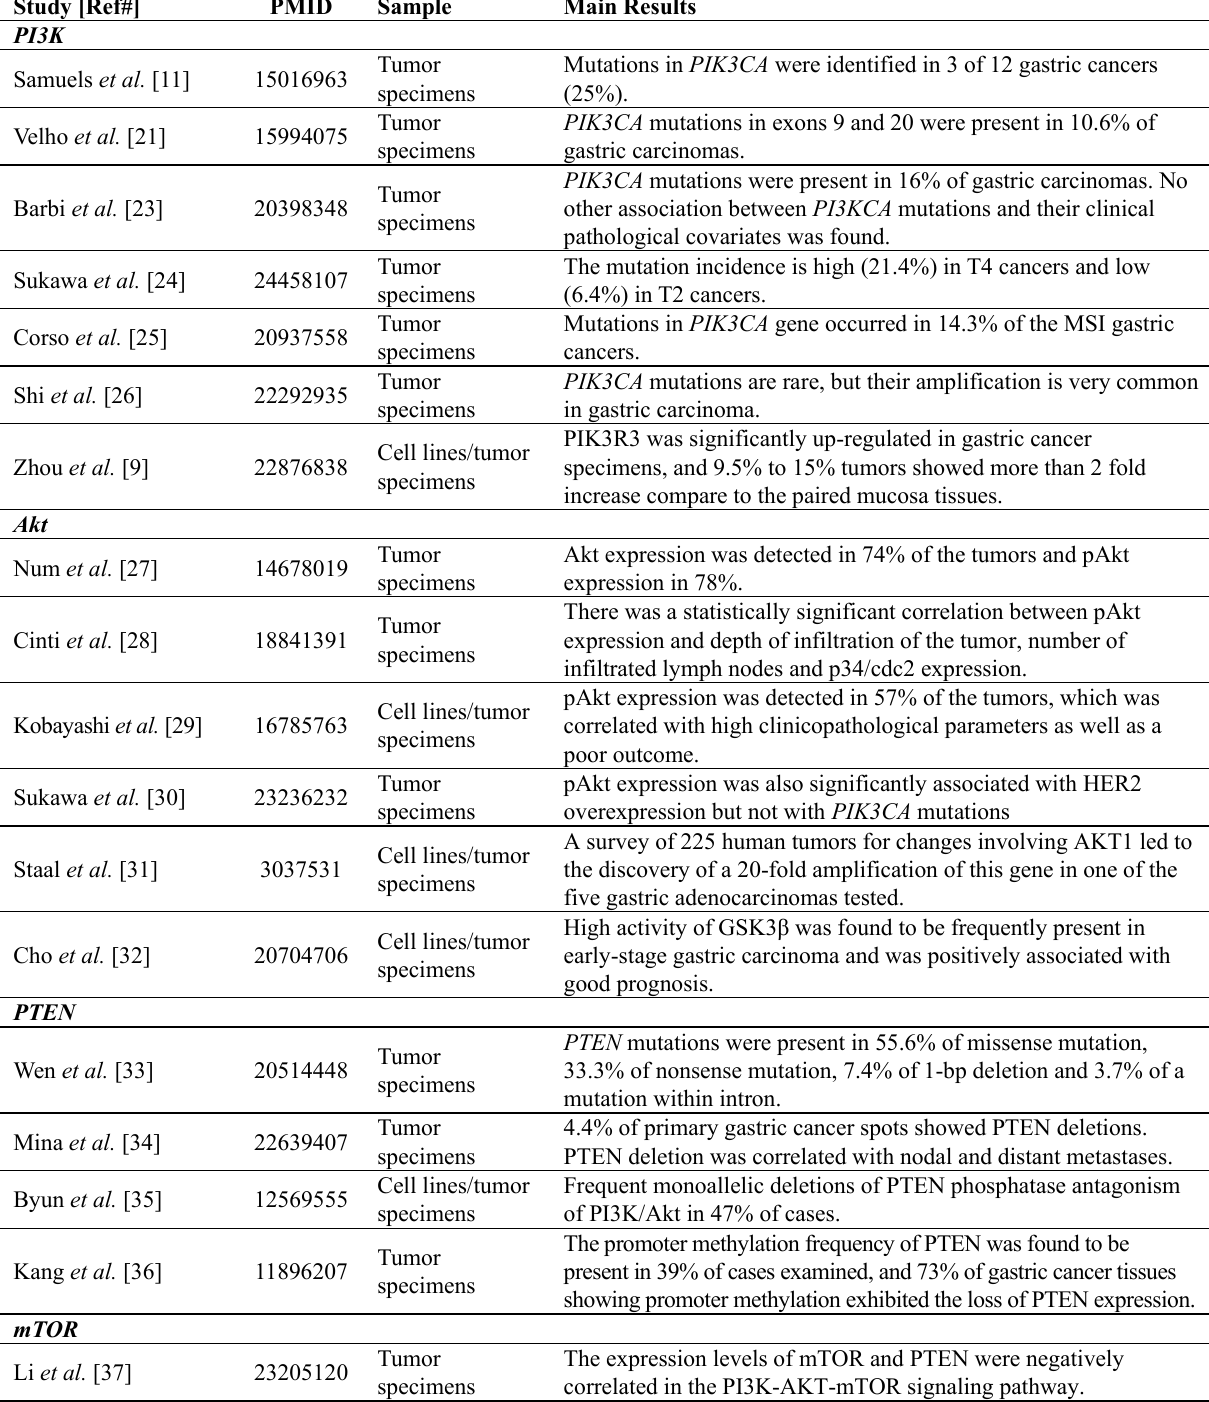
Table 1. Genetic alterations and activities of the PI3K/Akt/mTOR pathway in gastric